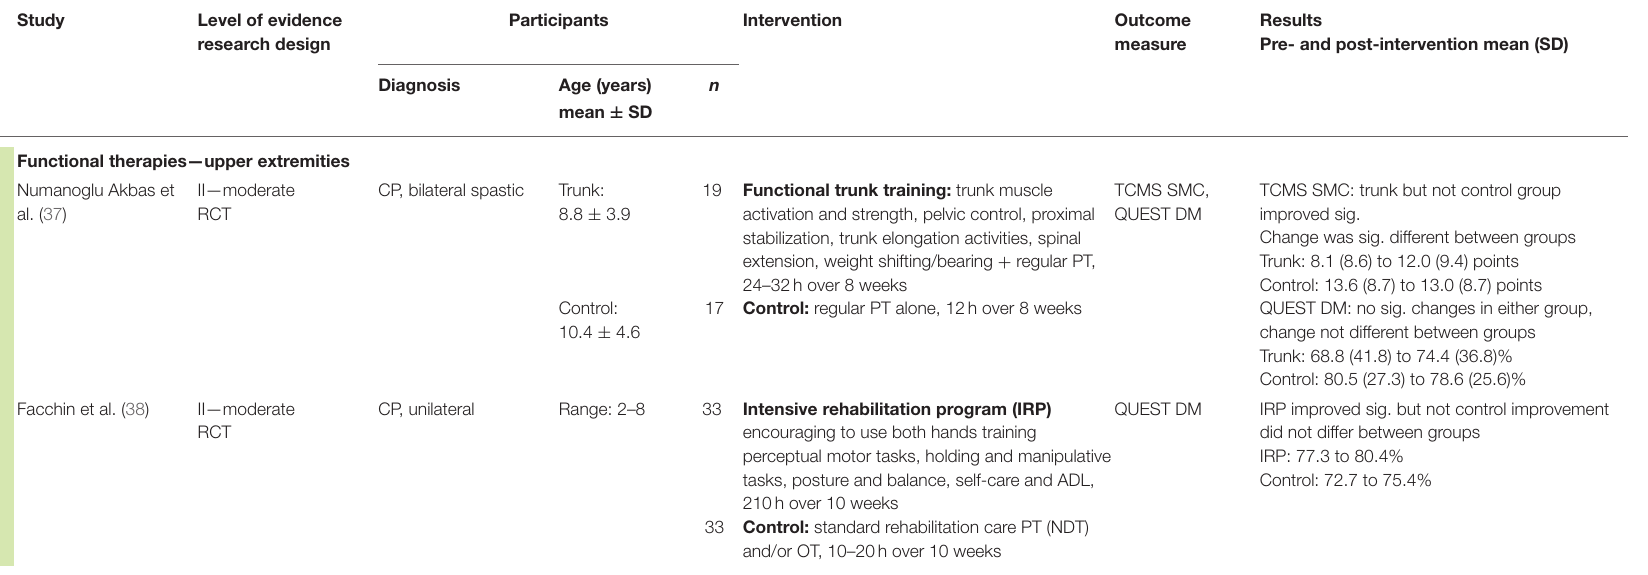
Intensive rehabilitation program (IRP) encouraging to use both hands training perceptual motor tasks, holding and manipulative tasks, posture and balance, self-care and ADL, 210h over 10 weeks Control: standard rehabilitation care PT (NDT) and/or OT, 10–20h over 10 weeks